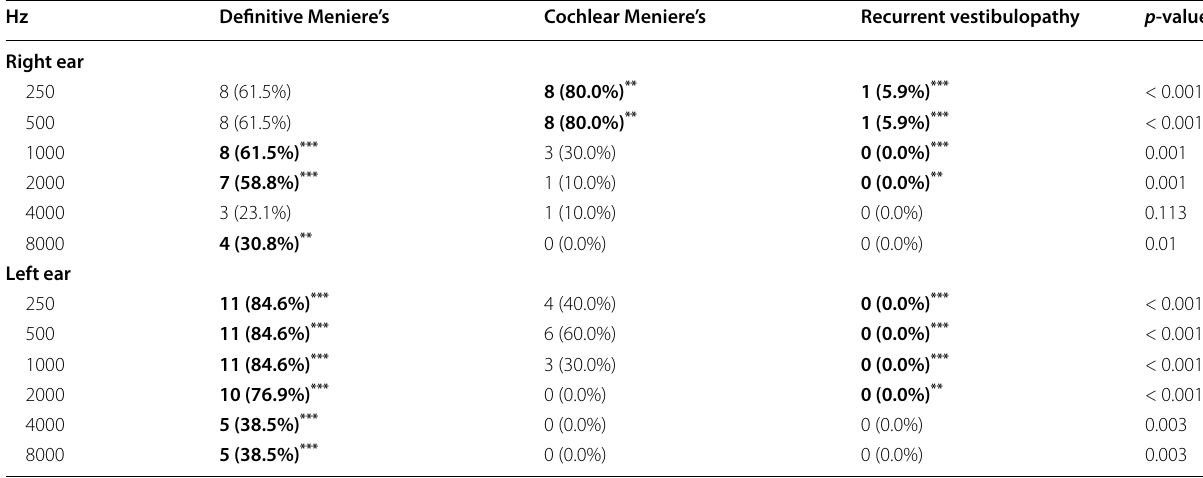
SNHL is significantly ( p < 0.001) different in the study groups. Post hoc testing revealed that SNHL is significantly higher in definitive Meniere’s ( p 0.005) than in the recurrent vestibulopathy group =